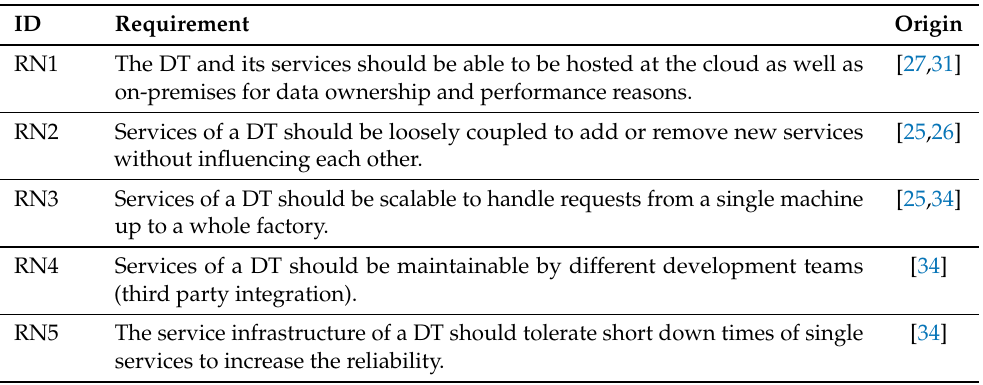
Table 1. Non-functional requirements.